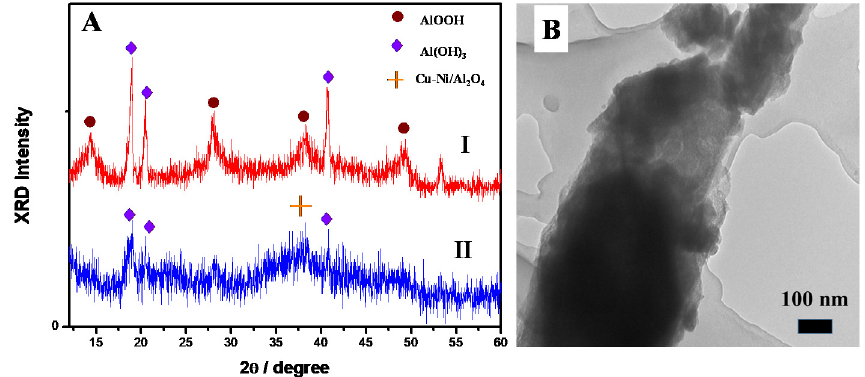
Figure 5. ( A ) XRD patterns of (I) active alumina and (II) copper hydroxide/nickel hydroxide/alumina mixture after hydrothermal reaction for 24 h. ( B ) TEM images ofalumina after calcination at 600 °C.